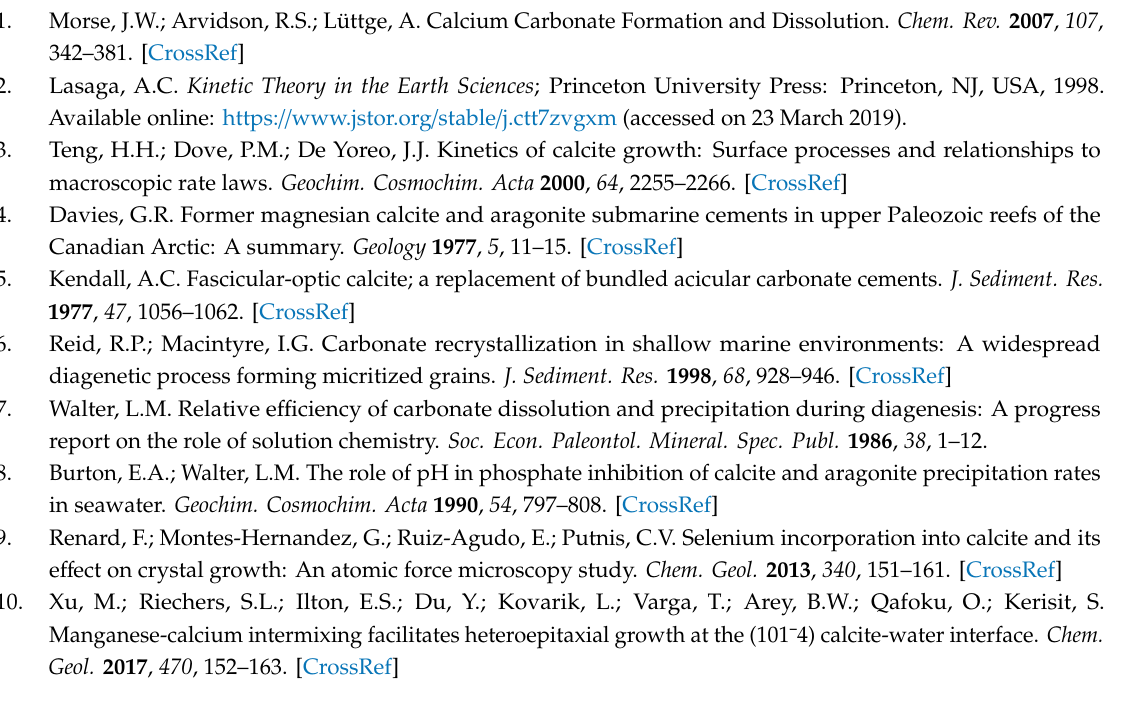
Figure S1. AFM height images of the calcite (104) cleavage surfaces in solutions at Mg 2 + / Ca 2 + = 0 and pH = 8.0 ± 0.1 with (a) SI calcite = 0.50; (b) SI calcite = 0.83; (c) SI calcite = 1.05. (d) Sketch of the atomic arrangements in calcite (104) surface. The cross-section illustrates the angular relationship of the acute and obtuse step edges with terraces. And SEM image with (e) SI calcite = 1.05; and (f) represents the image of the red box marked zone in (e); and (g) denotes the EDS analysis of P labeled in (f). Figure S2: AFM height images of the polished aragonite (110) surface in solution ( Mg 2 + / Ca 2 + = 0, SI calcite = 1.05) under flowing conditions at pH = 8.0 ± 0.1 for (a) 0, (b) 5, (c) 10, (d) 25, (e) 45 and (f) 80 min. Figure S3: AFM height images of the polished aragonite (110) surface in solution (Mg 2 + / Ca 2 + = 3 , SI = 1.05) under flowing conditions at pH = 8.0 ± 0.1 for (a) 0, (b) 2, (c) 5, (d) 10, (e) 20 and (f) 40 calcite